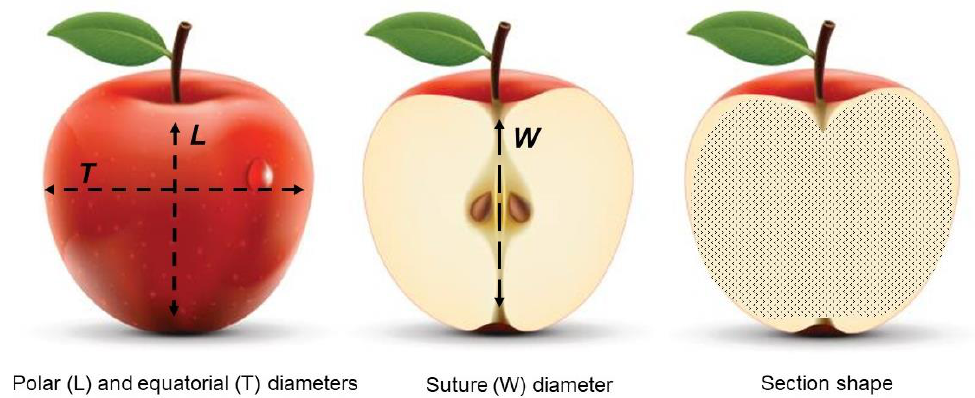
Figure 1. Schematic representation of the apple size and shape determination.